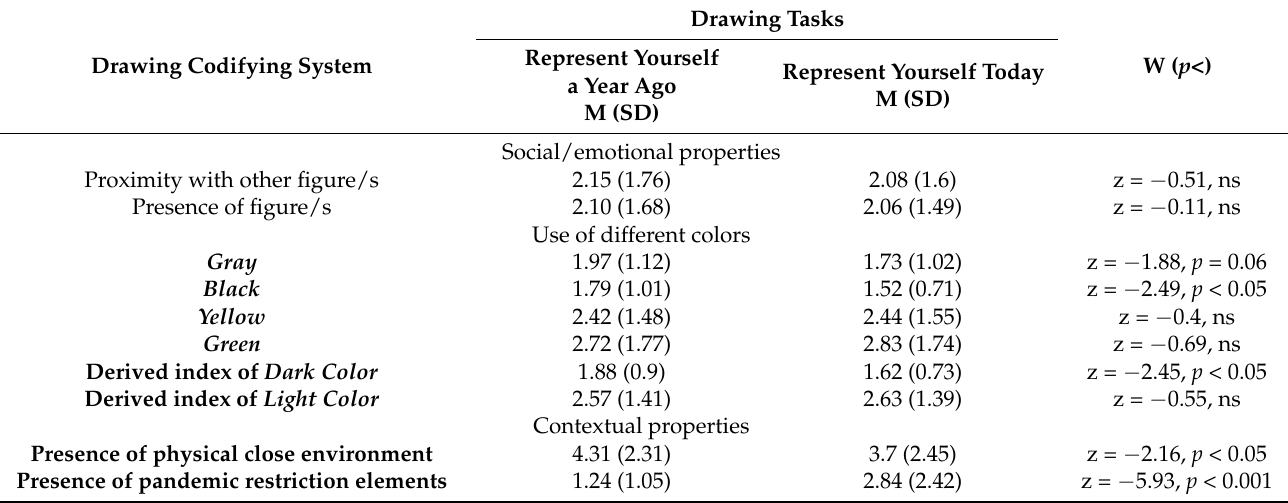
Table 5. Means and Standard Deviations of drawings’